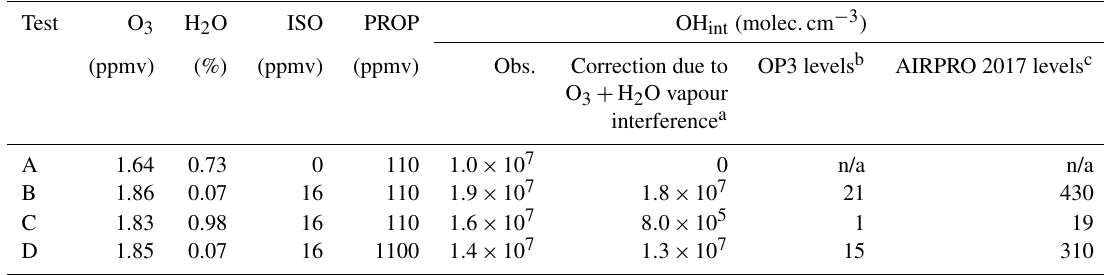
Table 3. Summary of interference tests with O 3 and isoprene (ISO) in the presence of propane (PROP), based on the data in Fig. 8. n/a – not